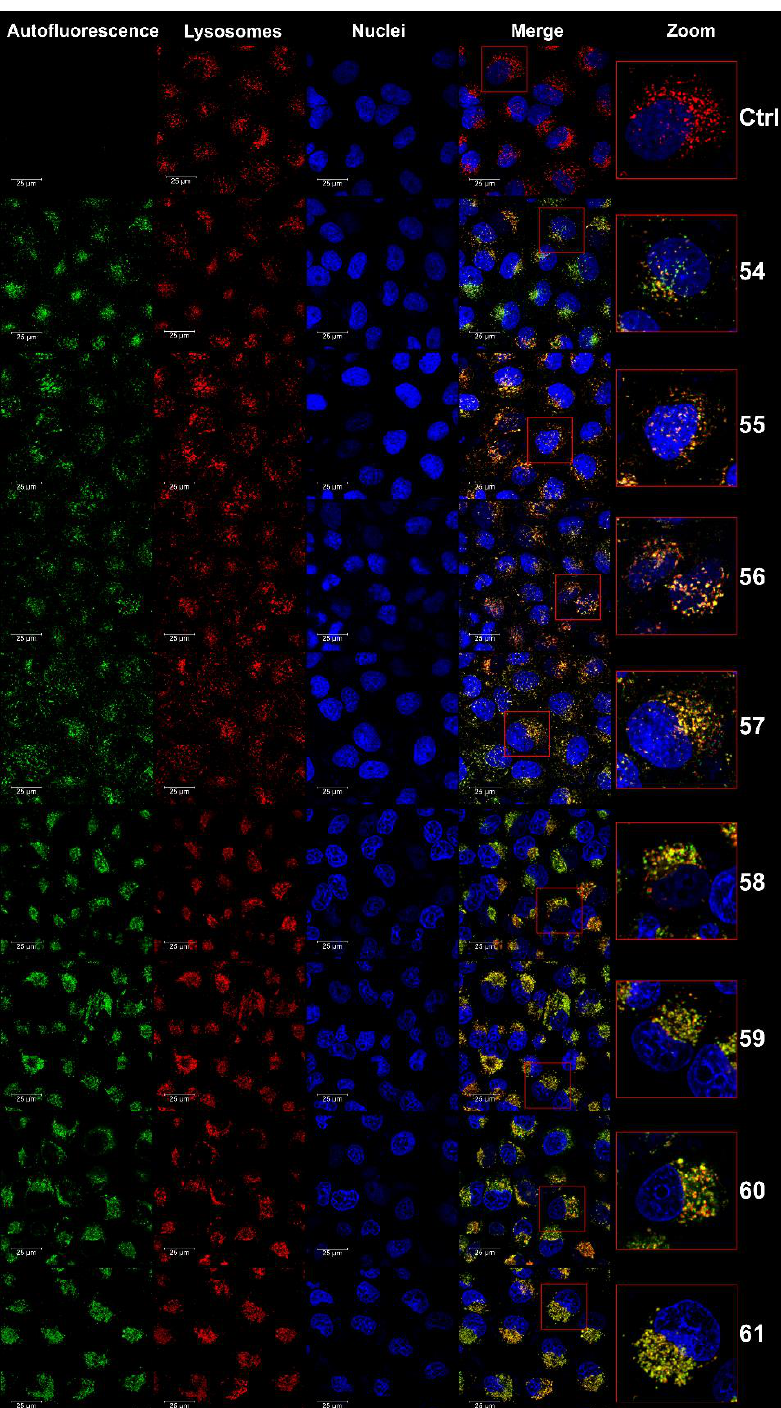
Figure 7. Colocalization analysis of compounds 54 – 61 in HepG2 cells by using confocal microscopy. This study was conducted after 24 h of treatment at the concentration corresponding to the total IC 50 values. Untreated cells were used as a control. Panels with green fluorescence show the autofluorescence of the investigated compounds (Ex/Em 488/500–600 nm). Lysosomes were stained with LysoTracker Red DND-99 (Ex/Em 561/585–655 nm; red), nuclei were stained with Hoechst 33342 (Ex/Em 405/430–480 nm; blue). Merged images are shown in the right panel. Green/red fluorescence signal reveals the potential colocalization of lysosomes and the analyzed compounds.